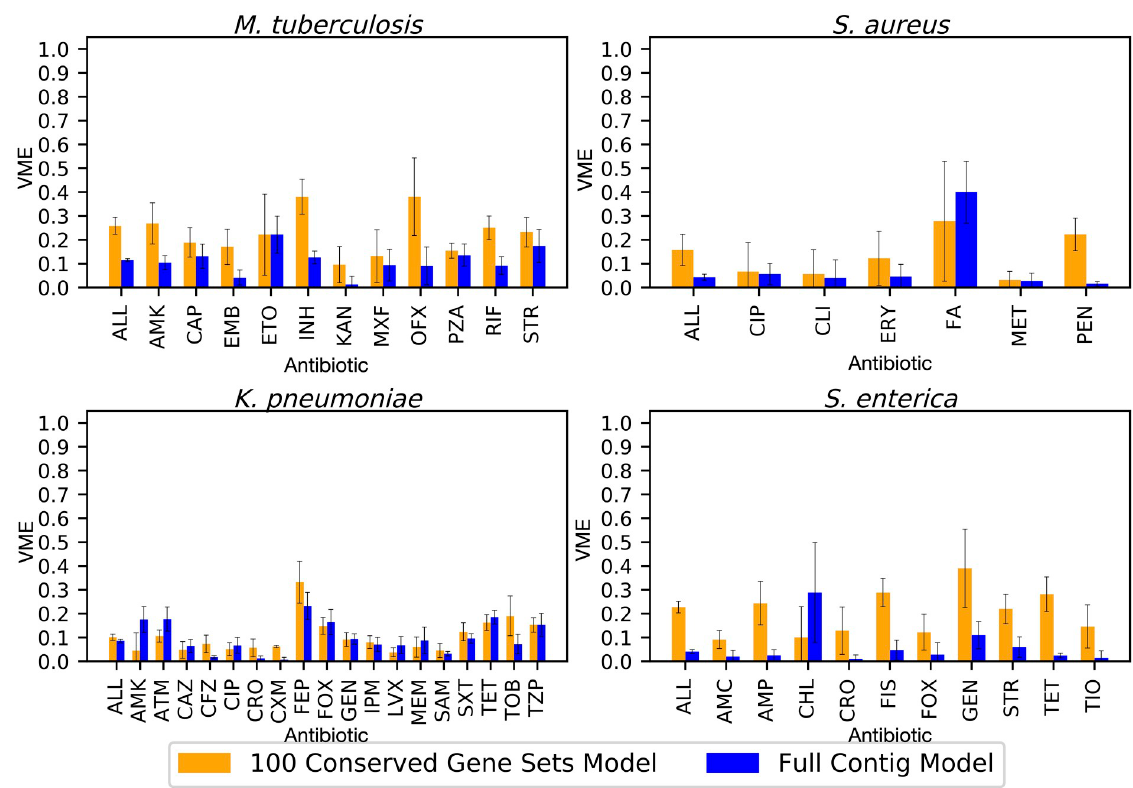
Fig 3. Average very major error rate (VME) by antibiotic for ten models built from non-overlapping sets of 100 randomly-selected core genes (orange bars) compared with the VME for models built from whole assembled contigs for the same genomes (blue bars). VMEs are defined as resistant genomes being incorrectly classified as susceptible. Error bars represent 95% confidence intervals for the whole genome model, and the minimum and maximum confidence interval observed in all ten replicates for the core gene models. Antibiotic abbreviations are defined in Table